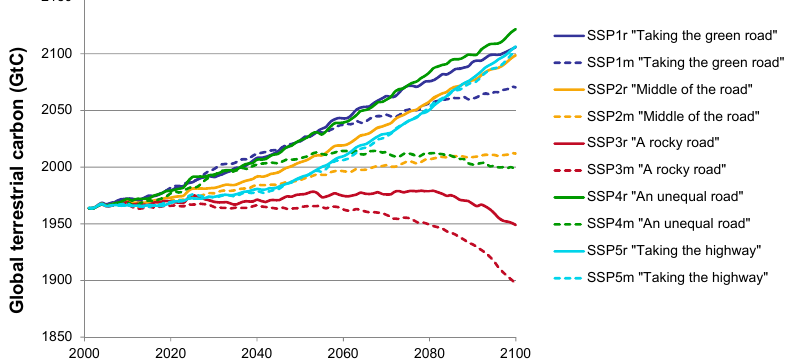
Figure 9. Changes in global terrestrial biosphere carbon pool (GtC) from 2000 to 2100 for all SSPs, reference (r) and mitigation (m) case. The slope indicates whether the net ecosystem carbon balance (NECB) is a carbon source (negative slope) or carbon sink (positive